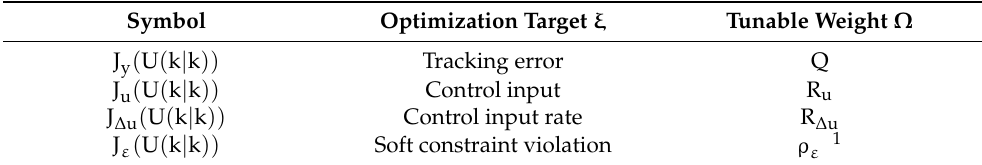
Table 3. QP cost function parameters legend.